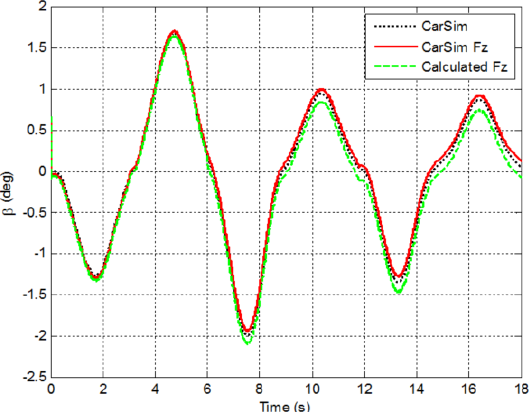
Fig. 8: Estimation of the vehicle side-slip angle for steering angle δ (cid:54) = 0